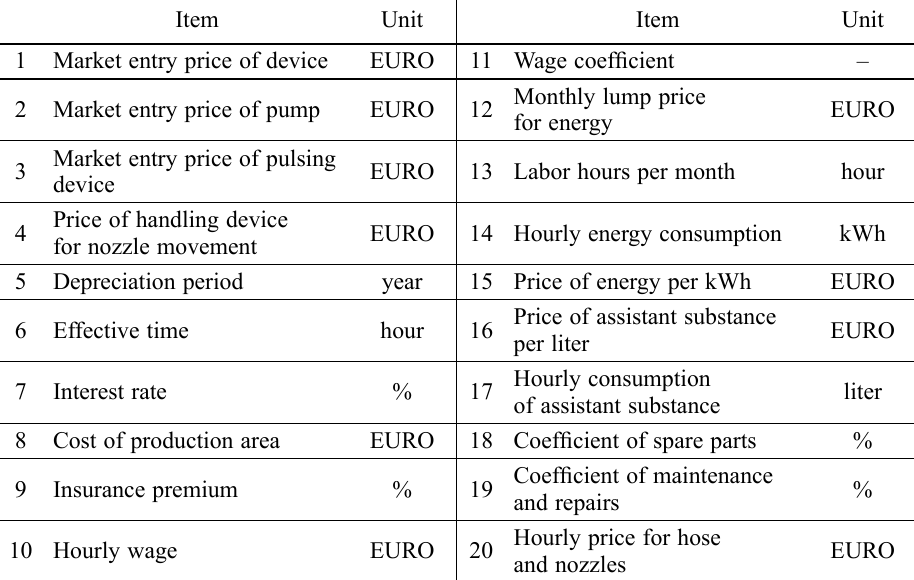
Table 1. Example of items in computation model for calculation of fixed and variable